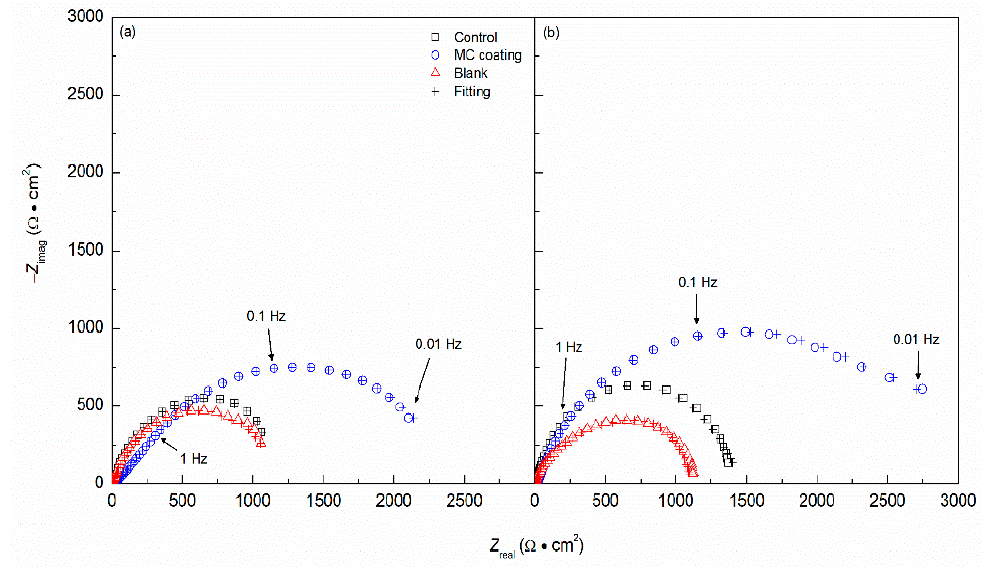
Figure 7. Nyquist plots obtained from EIS for mild steel with acrylic coating modified with colophony microcapsules exposed to 3.5 wt% NaCl in ( a ) DI water (pH = 6.8), and ( b ) SCPS (pH = 12.6).